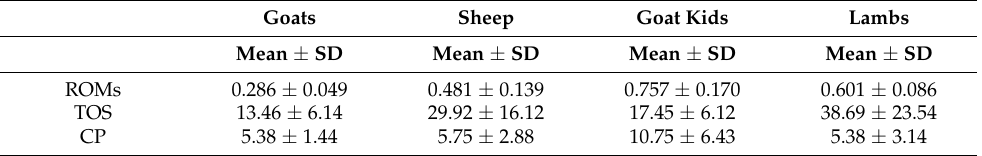
Table 2. Mean ( ± SD) values of the LOOH content evaluated using ROMs and TOS assays and the ceruloplasmin (CP) oxidase activity in blood serum of Grigia lucana goat adults (n = 5) and kids (n = 5), and Italian Merino-derived ewes (n = 5) and lambs (n = 5).